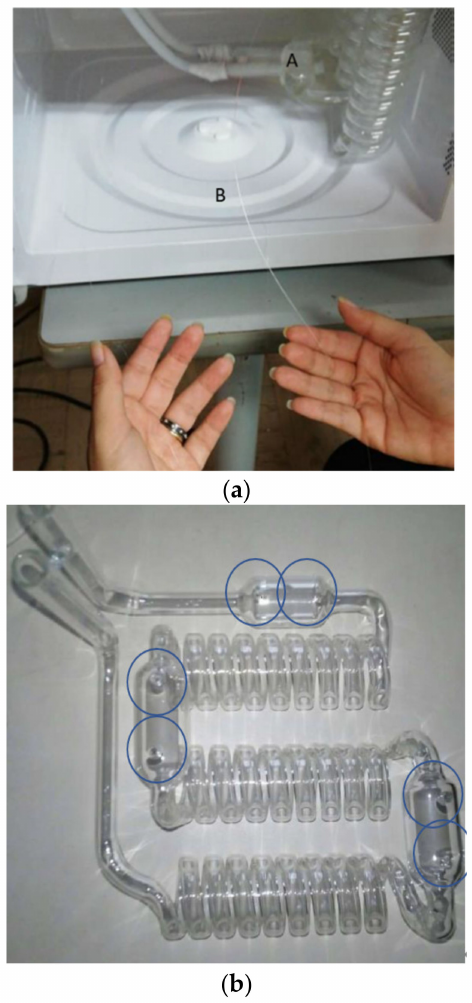
Figure 4. Glass structure installed inside the microwave with an optical fiber temperature sensor placed inside the bulbs. ( a ) A: Optical fiber installed inside the bulb. B: Optical fiber inside the microwave oven. ( b ) Holes on the glass structure shown by highlighted blue circles. FBG temperature sensors (FBG 2, FBG 3, FBG 4) will be installed through the